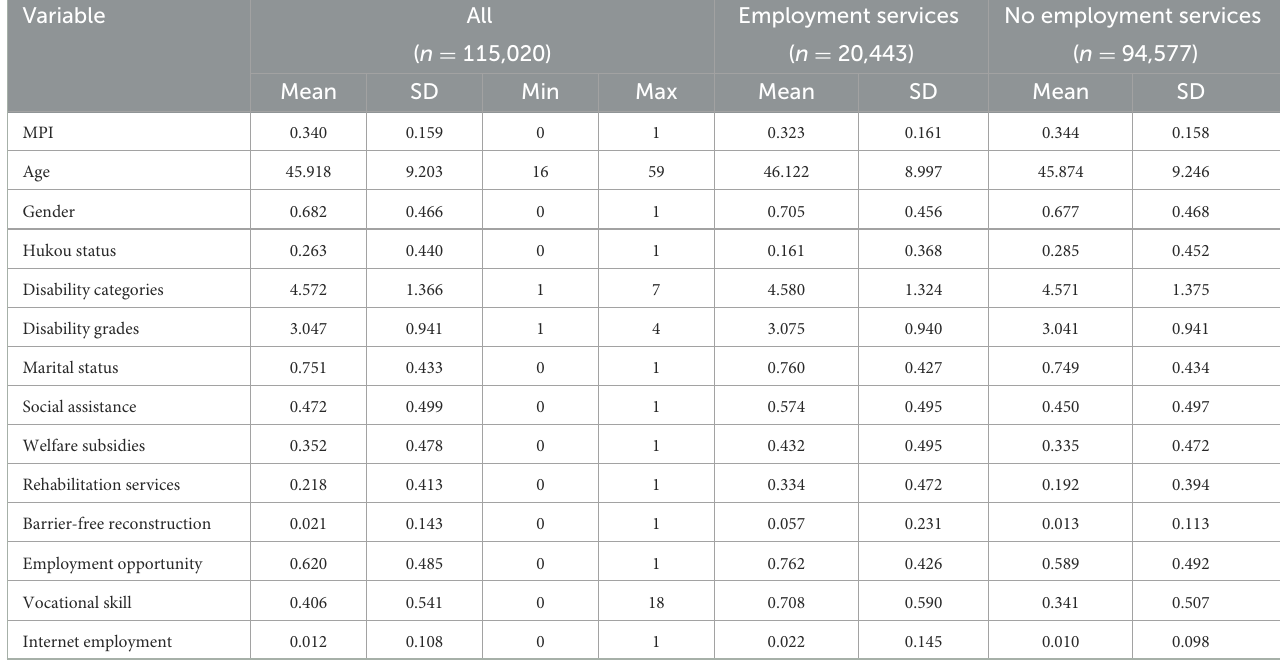
TABLE 6 Descriptive statistics of variables.